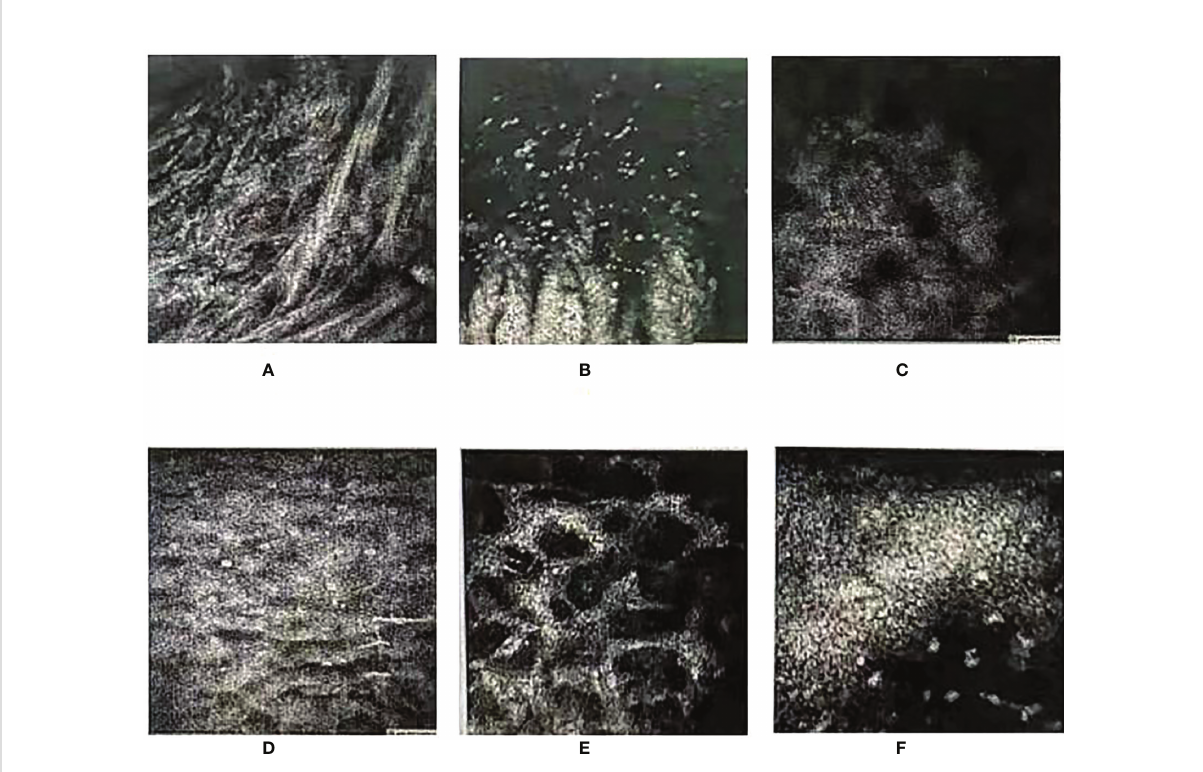
FIGURE 4 In-vivo histology of the cornea (zeiss63X, FOV400 m m). (A, B) Below the cornea of the left eye, the epithelial layer of the lesion was found to be defective. Many streak-like hyper-re fl ections and no normal epithelial cells were observed. (C, D) Deep structures were not imaged. Epithelial cells of the corneal epithelium in the clear zone above the lesion were swollen, and subepithelial nerve fi bers were not observed. (E, F) The super fi cial stromal layer was slightly turbid, and the deep stromal cells were activated. The shape of endothelial cells was good, and there were a large number of punctate hyper-re fl ections observed in the endothelial